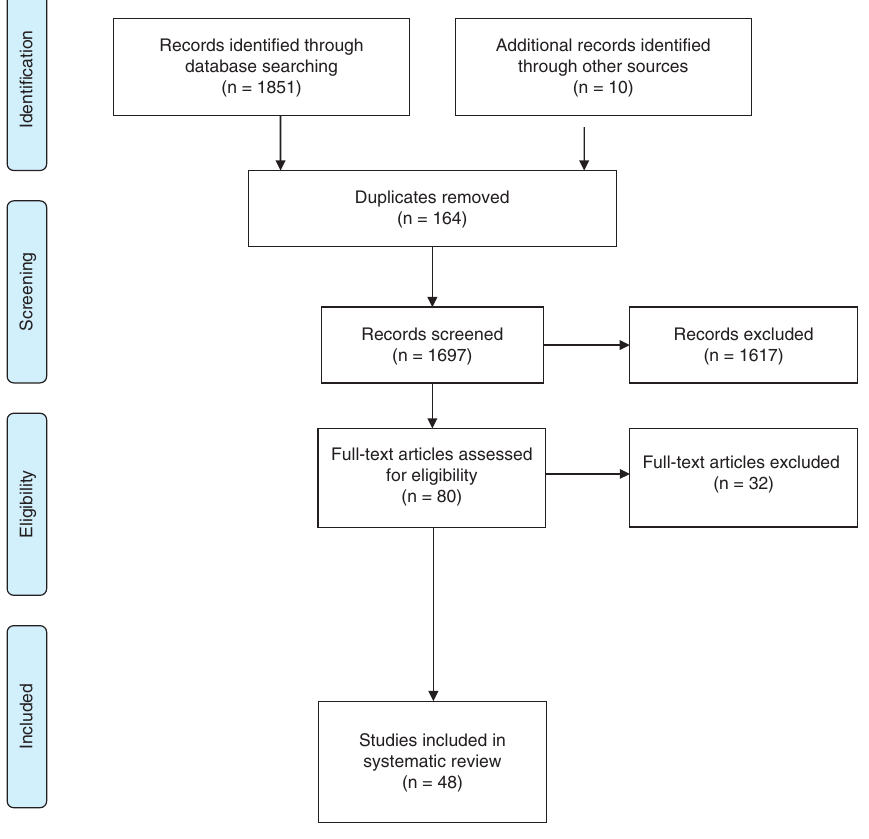
Figure 1: PRISMA flow